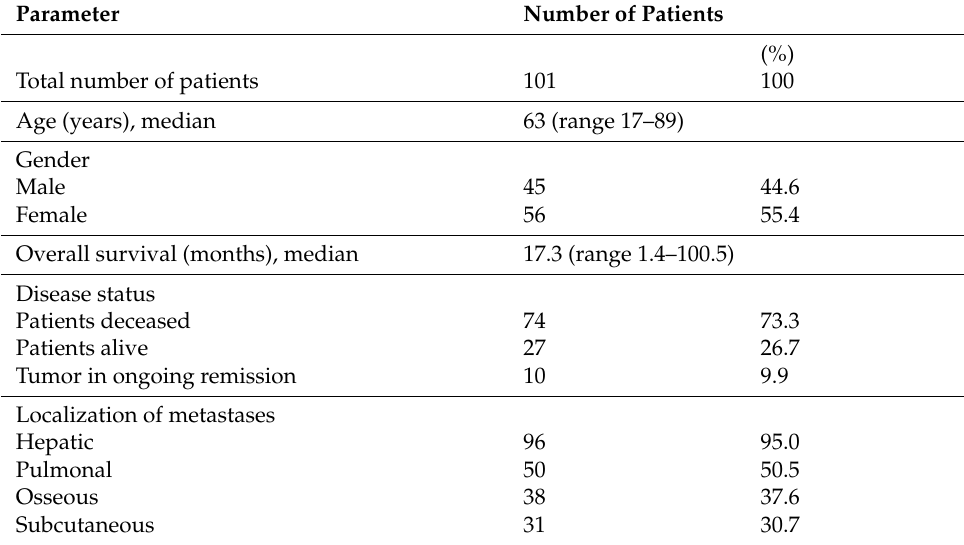
Table 1. Patient characteristics. * Other liver directed treatment included chemoperfusion in 6 patients, selective internal radiation therapy (SIRT) in 4 patients and transarterial chemoemboliza- tion (TACE) in 2